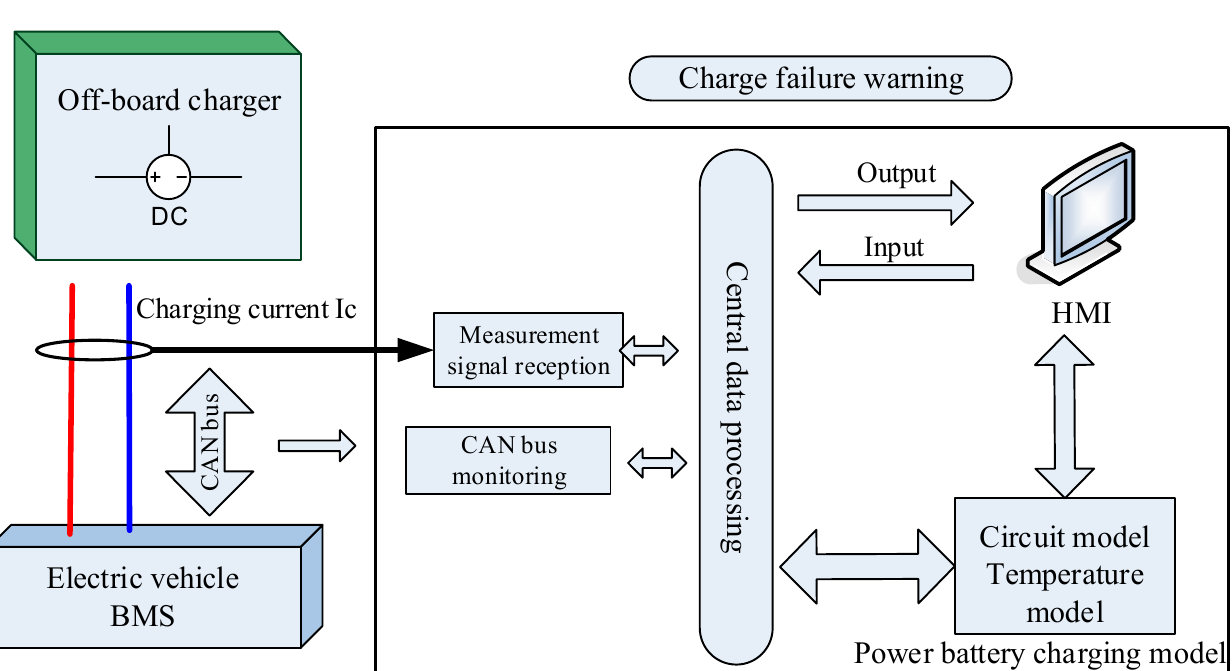
Figure 1. Functional structure diagram of monitoring and early warning method for electric vehicle charging fault, based on the battery model.